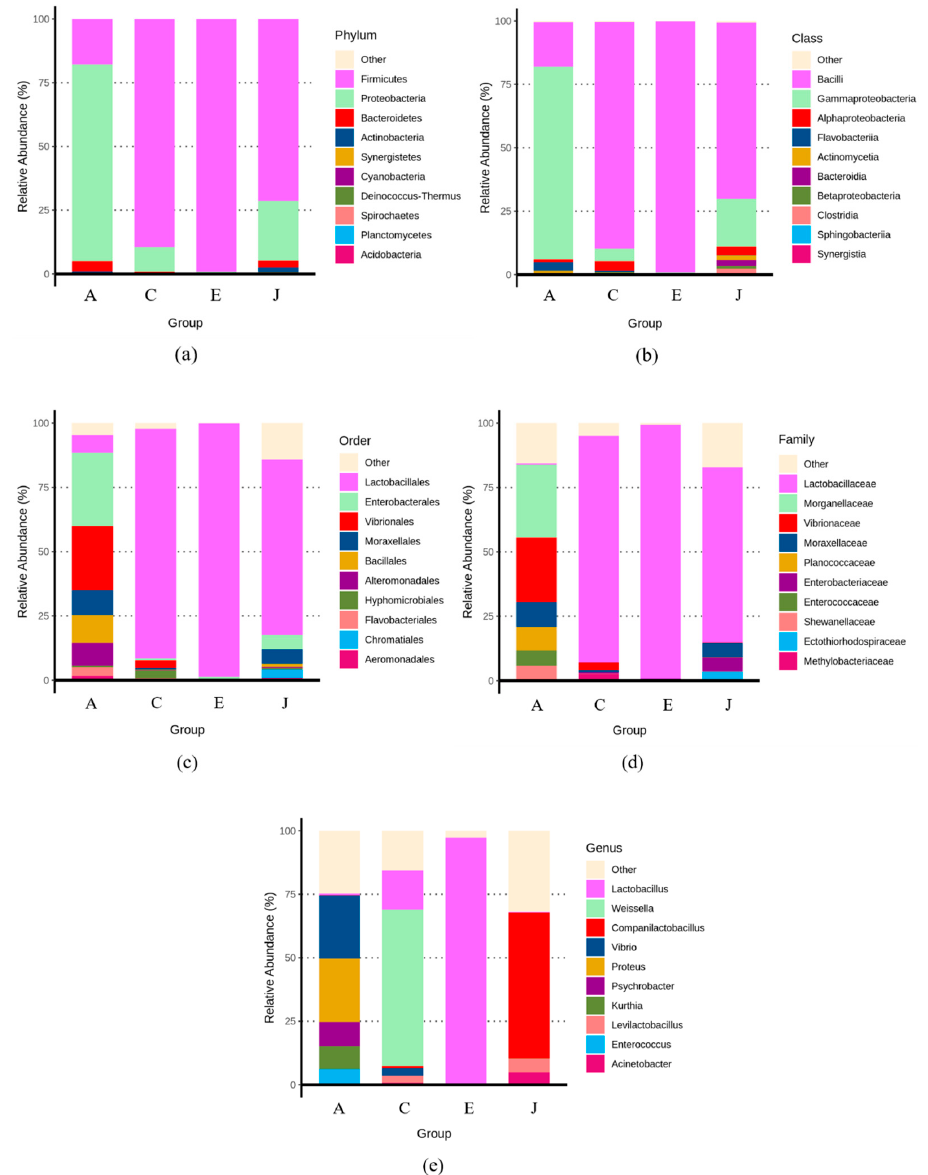
Figure 2. Bacteria species annotation of A, C, E, and J mustard pickle products in retail market on levels of phylum ( a ), class ( b ), order ( c ), family ( d ), and genus ( e ).